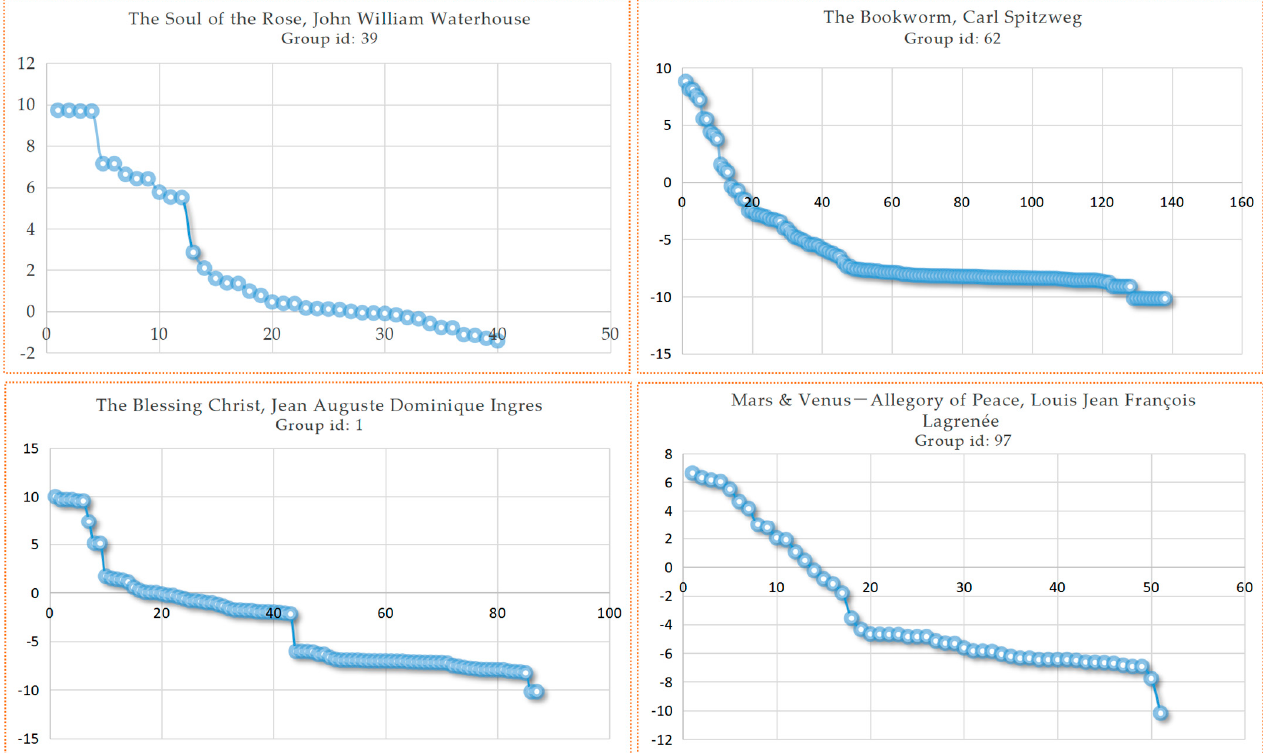
Figure 2. Distribution of the predicted ranking score for the 4 common artworks (memes).